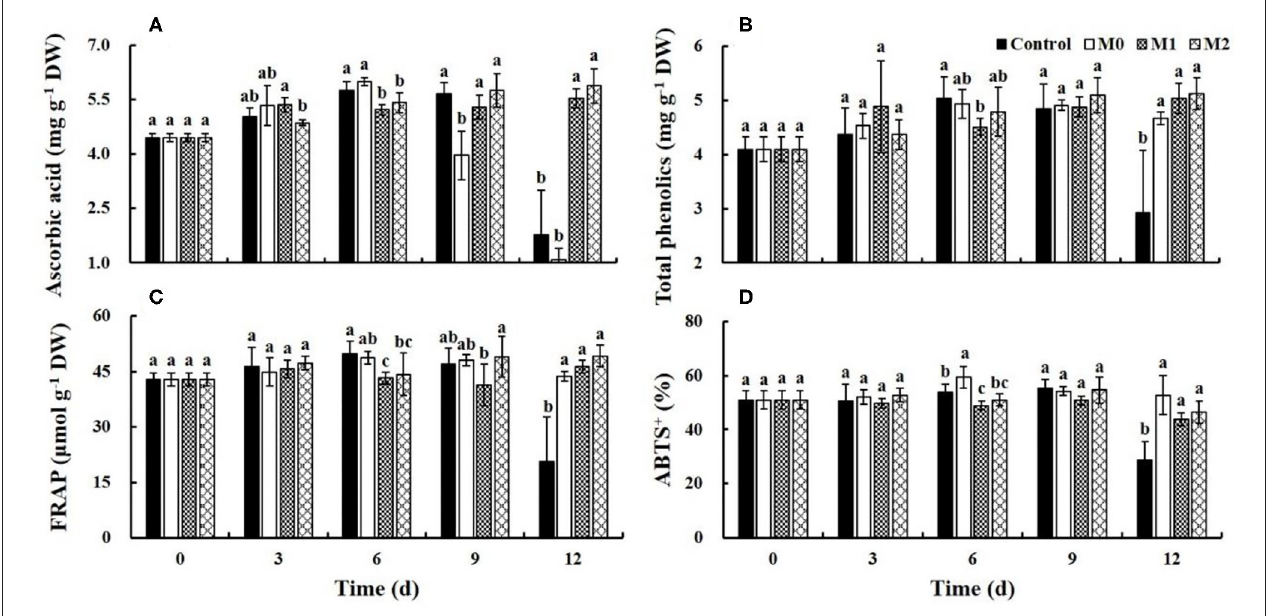
FIGURE 4 | The main antioxidants content and antioxidant capacity level of different baby mustard lateral buds during storage at 4 ◦ C under different MAP treatments. (A) Ascorbic acid content; (B) total phenolics content; (C) FRAP level; (D) ABTS + level. Different letters in the figure indicate statistically significant differences among treatments for each storage day ( P < 0.05). M0 indicates packaging with no holes; M1 indicates packaging with 6mm in diameter holes; M2 indicates packaging with 12mm in diameter